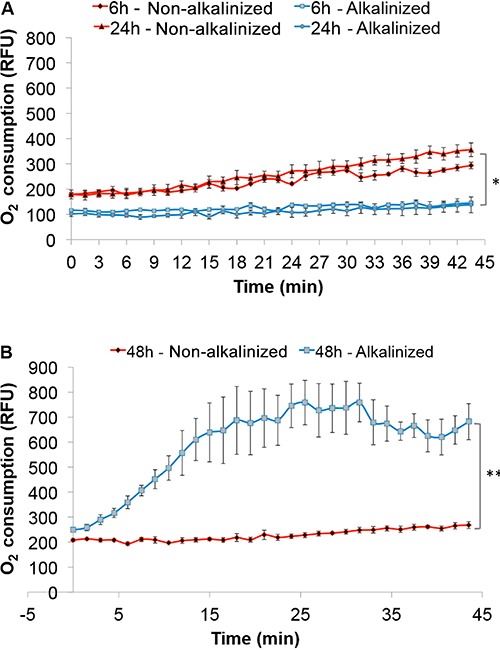
Extracellular O2 consumption of breast cancer stem cells after 6- and 24-h incubation (A) and after 48-h incubation (B) measured by fluorometry. RFU: relative fluorescence units. Data are reported as means±SE. *P<0.05; **P<0.01, one-way ANOVA.